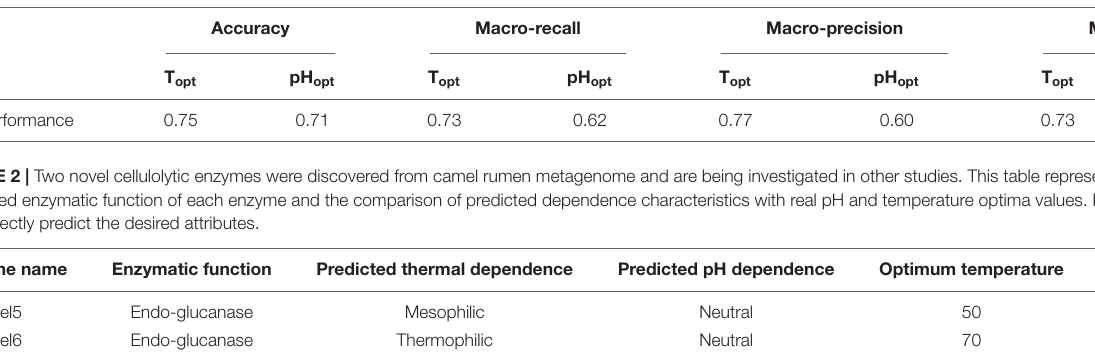
TABLE 1 | MCIC’s prediction performance during 100 iterations of sixfold CV tests.